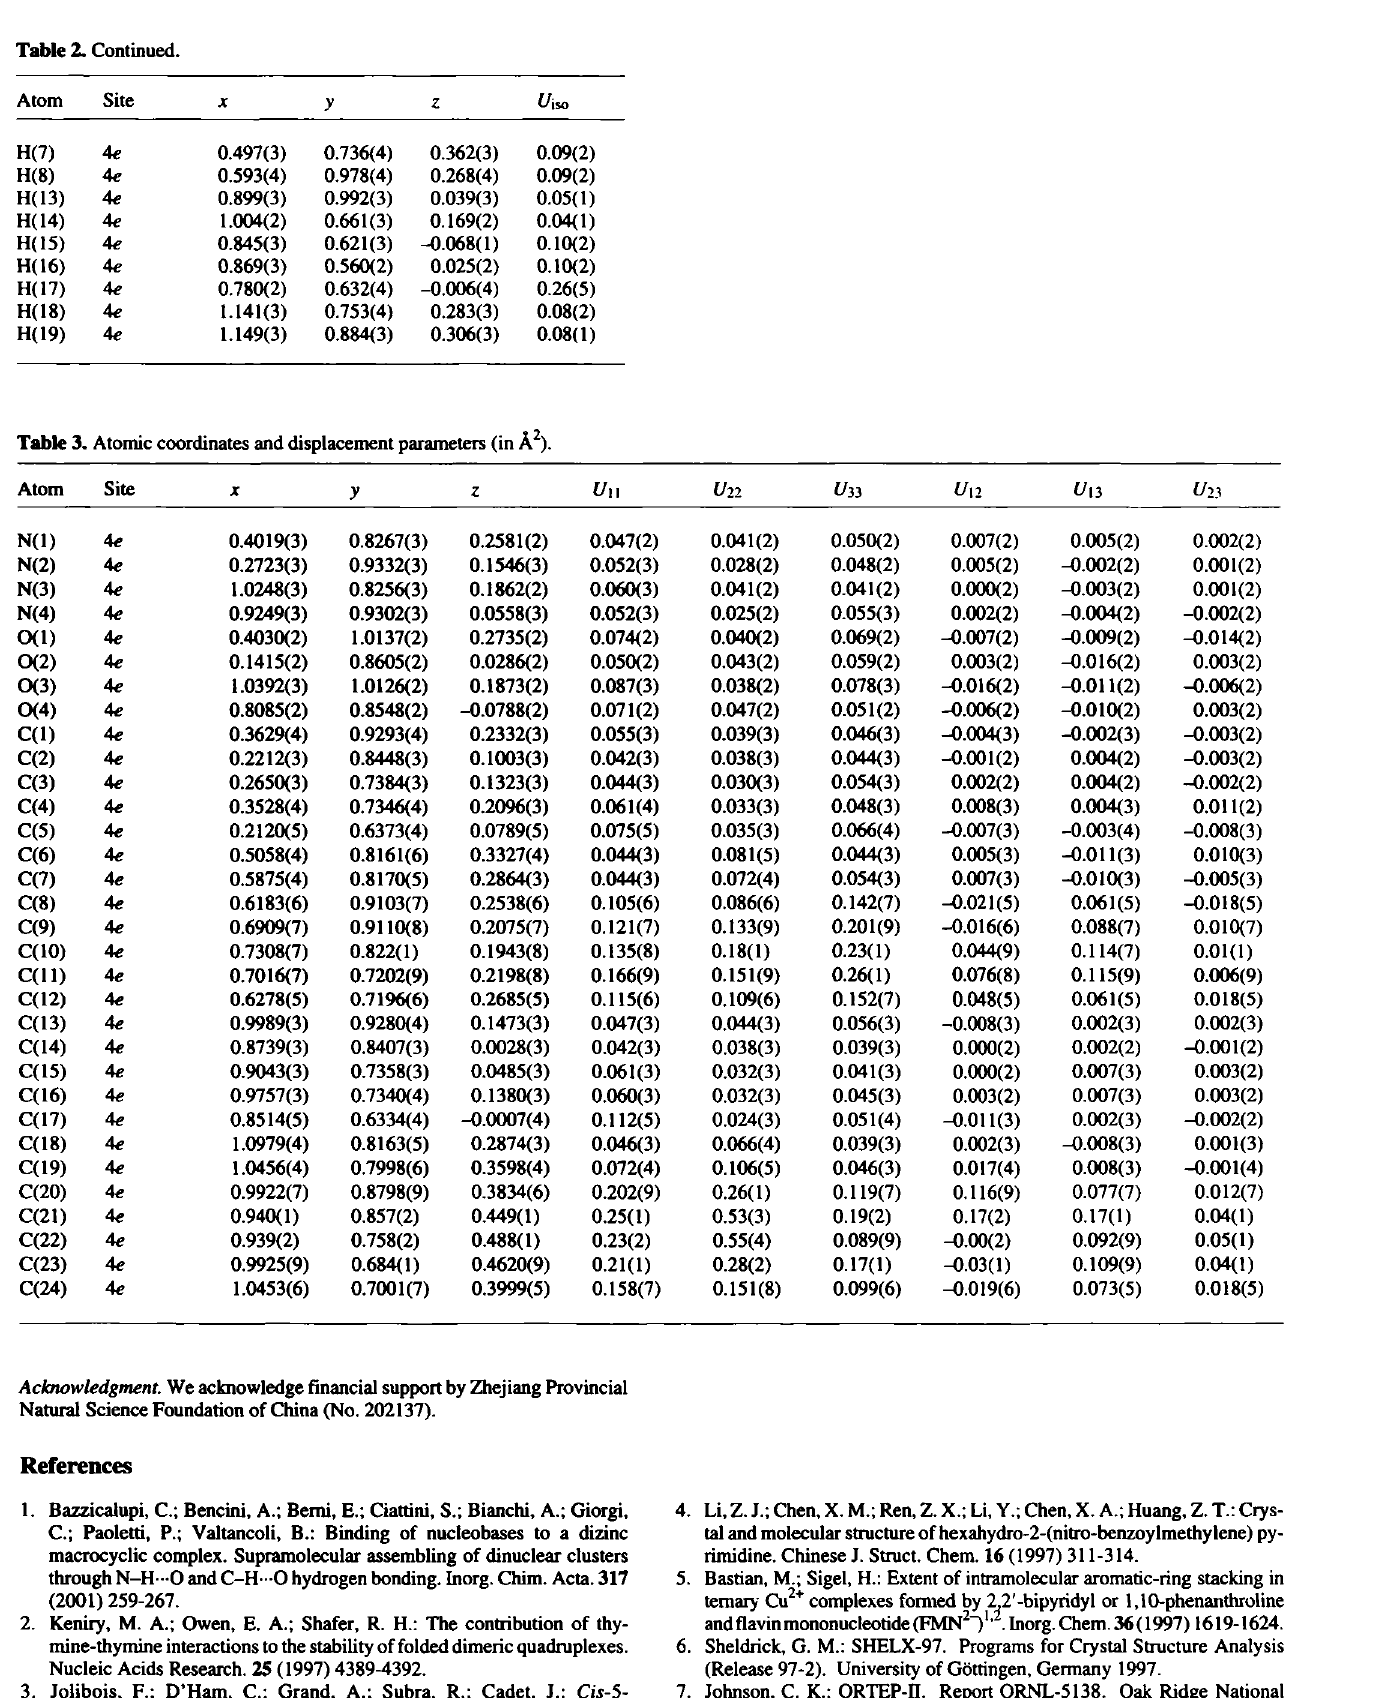
Table 3. Atomic coordinates and displacement parameters (in Â 2